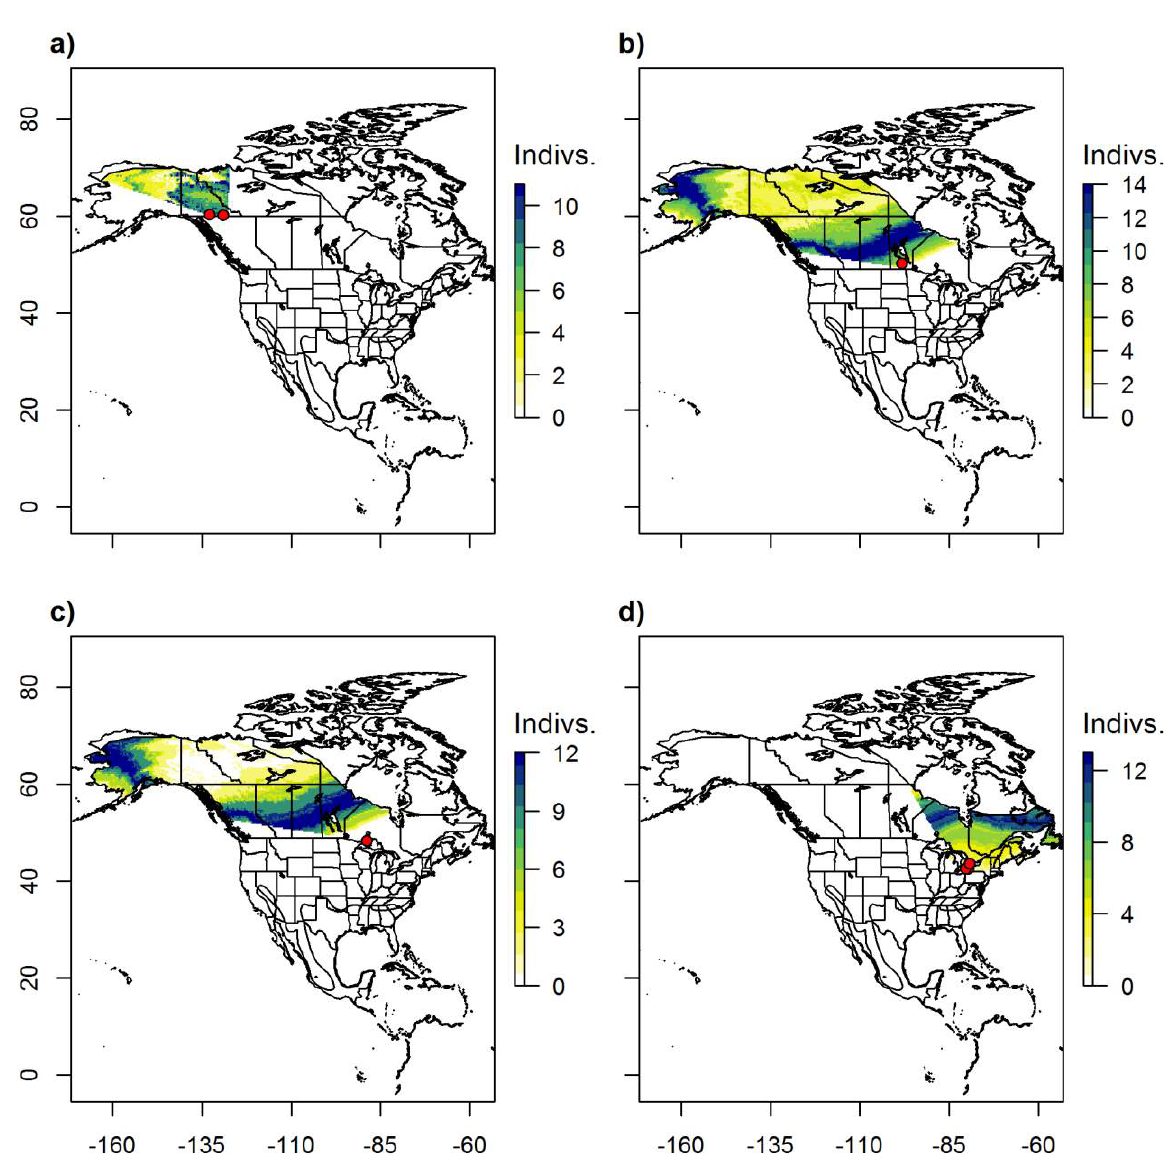
Figure A2.16: Probable origins of Yellow Warblers ( Setophaga petechia ) captured during spring migration at CMMN stations in a) the Yukon (ACBO (n=11), TLBBS (n=10)); b) Manitoba (DMBO (n=21)); c) Western Ontario (TCBO (n=17)); and d) Southwest Ontario (HBO (n=5), LPBO (n=9), PIBO (n=3), TTPBRS